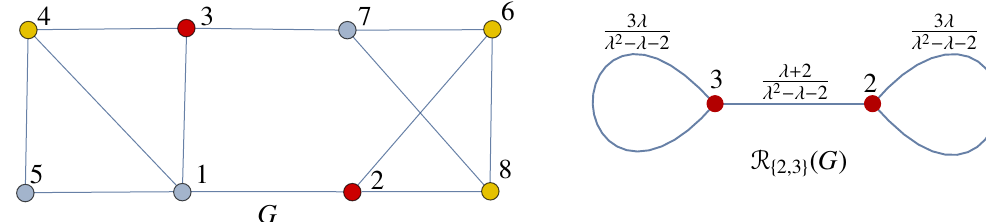
Fig. 2 An example of an unweighted, undirected graph G and its corresponding adjacency matrix M ( G ). The graph has the symmetry given by the automorphism φ = (68). The symmetric vertices 6 and 8 are highlighted yellow.